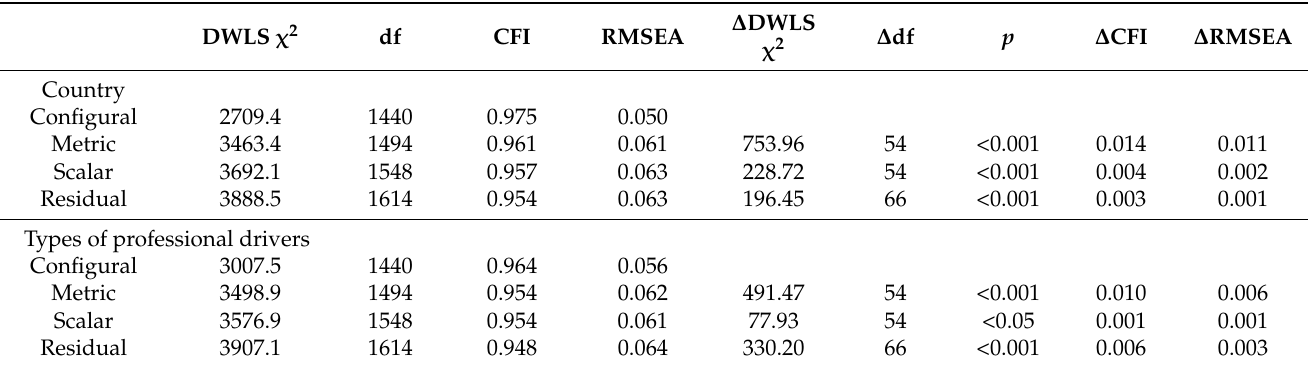
Table 5. Measurement invariance of the original measurement model of the DAS across countries and types of professional